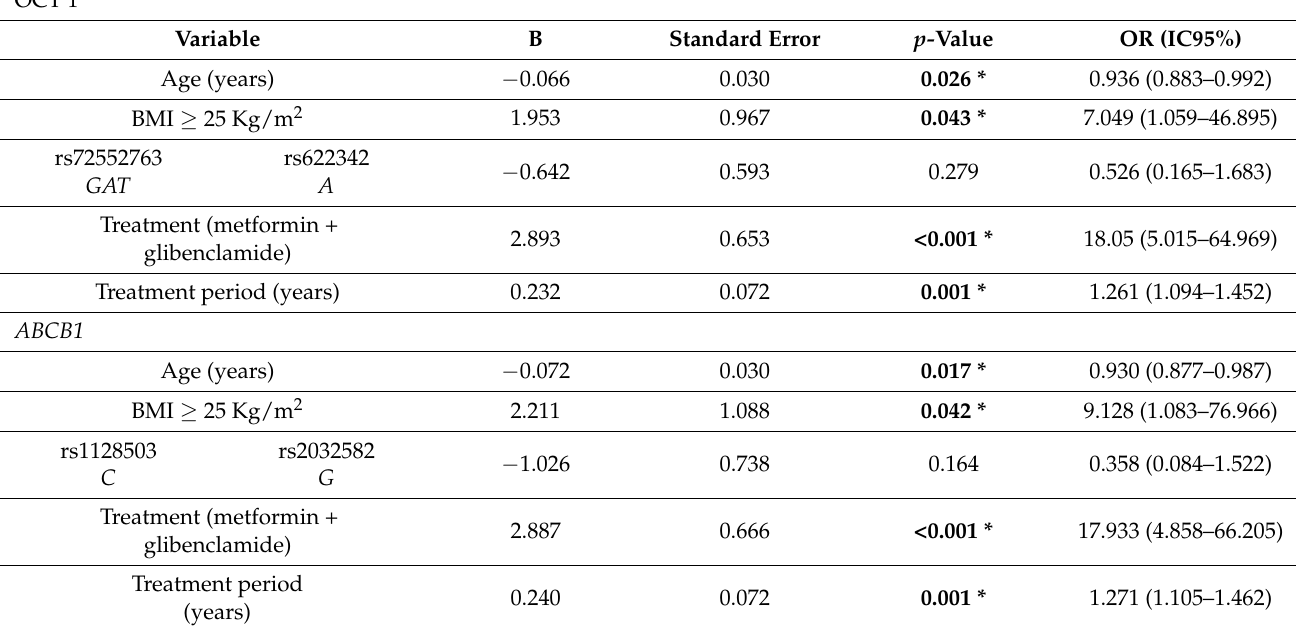
Table 7. Multiple logistic regression on HbA1c no-control using a dominant genotype model for SLC22A1 and ABCB1 ( n =